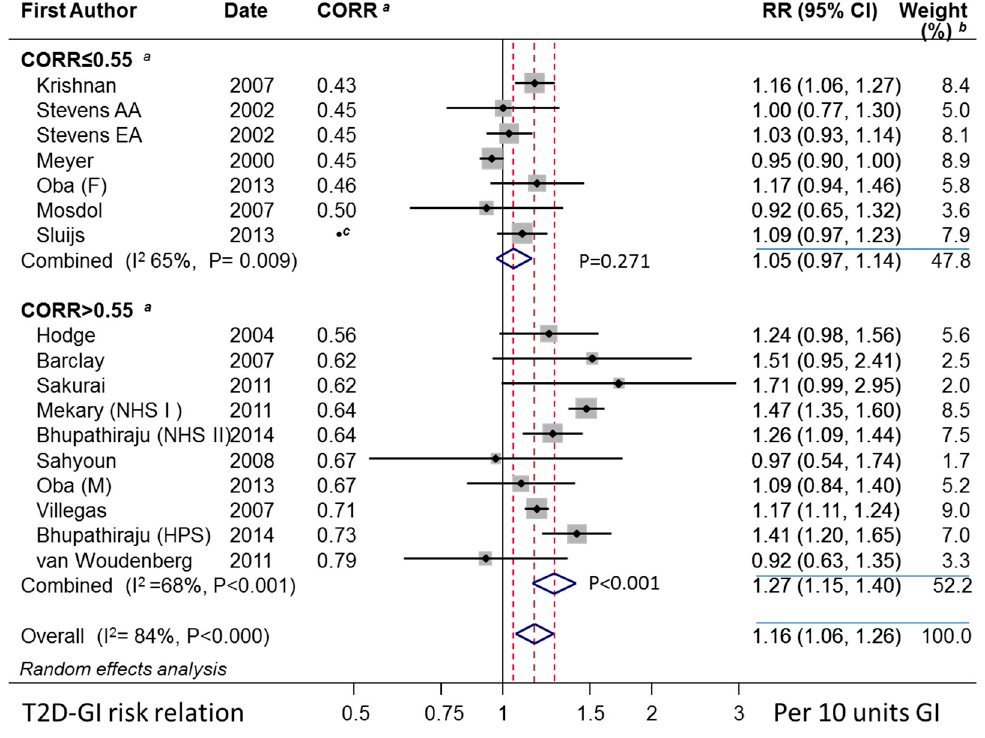
Figure 3. Forest plot of the dose-response T2D–GI risk relation by validity of the dietary instrument. The box size is proportional to the weight contributed by the study to the combined study mean. Horizontal lines span individual study 95% confidence intervals. Arrowheads indicate truncations. Diamonds represent the combined study mean RR values per 10 GI units (based on the glucose standard), and the corresponding 95% CI values. Analysis was undertaken on the natural logarithms and are shown untransformed. p -Values were calculated using the z test for RR and the Chi 2 test for I 2 . Eligible studies were: Barclay et al. (2007) [68], Bhupathiraju et al. (2014) (NHS II) [10],